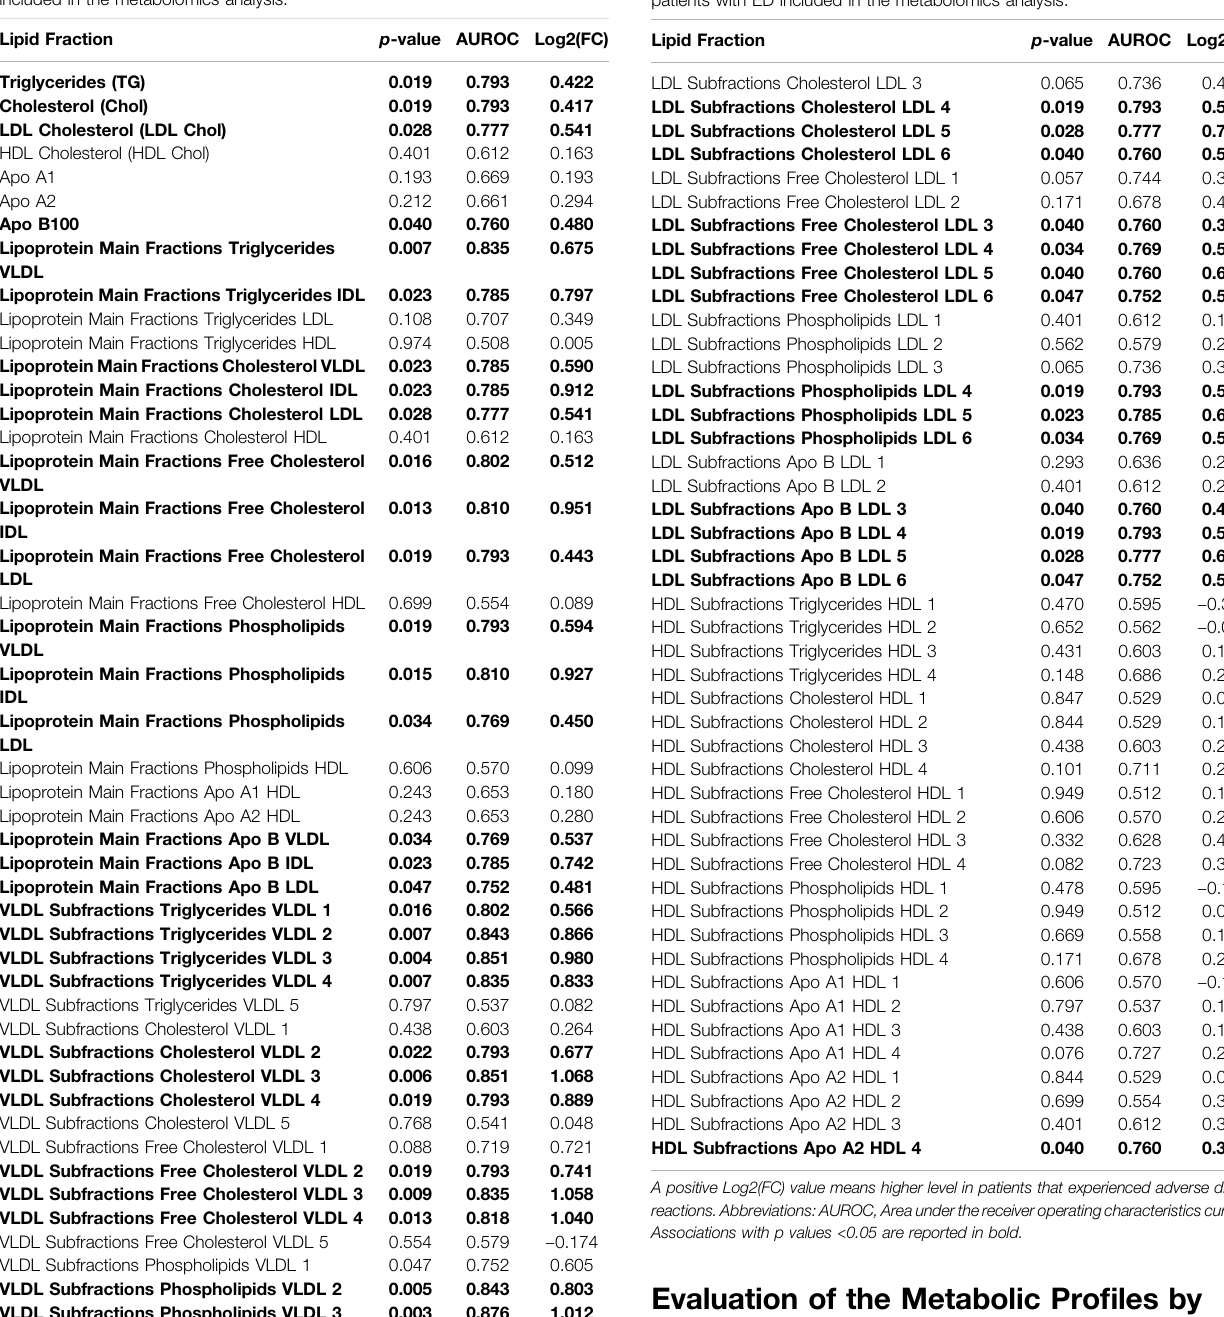
TABLE 4 | ( Continued ) Lipid analysis in serum samples from the 26 out of 28 patients with ED included in the metabolomics